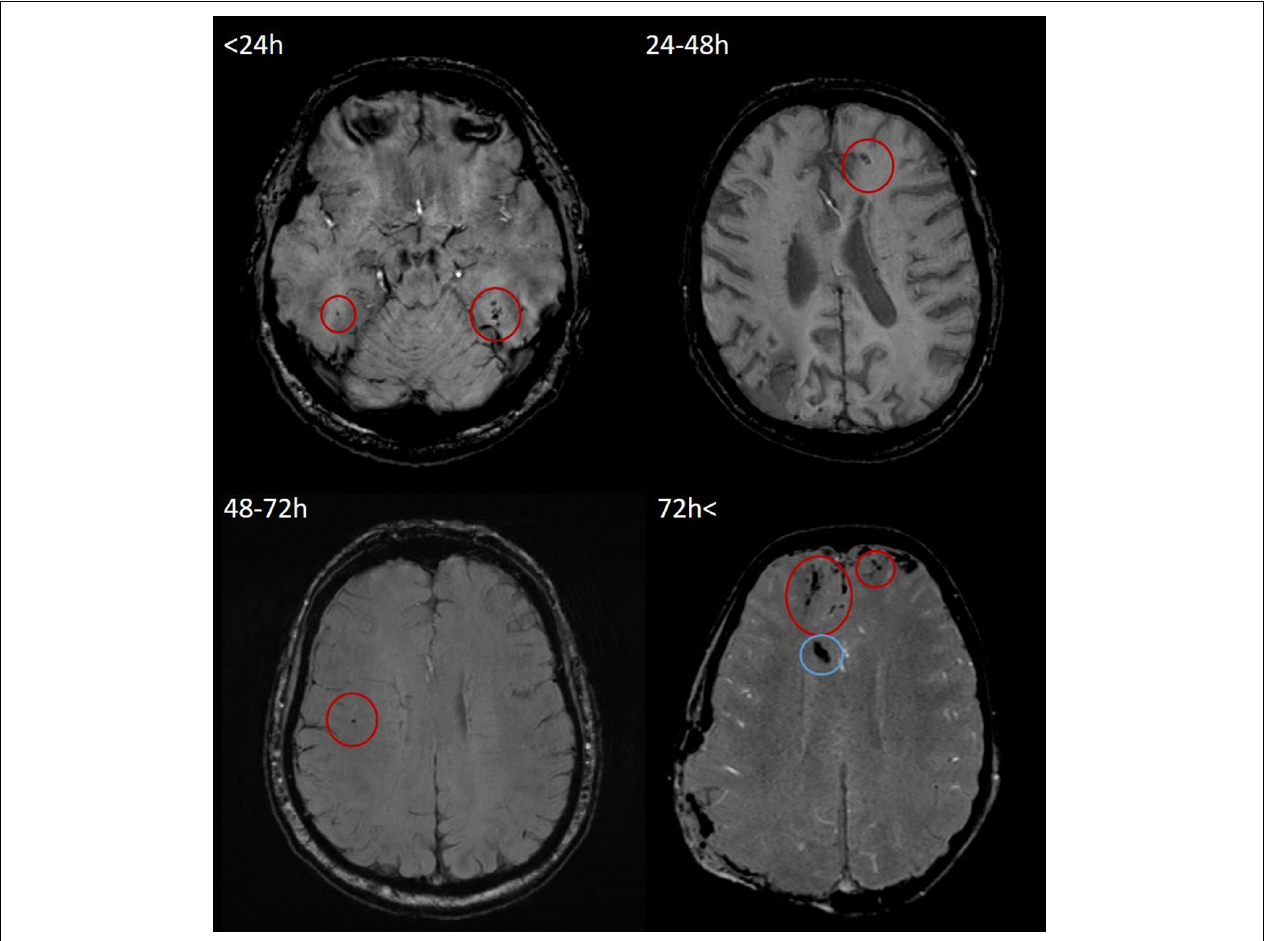
FIGURE 2 | Representative examples of TMBs in SWI images in < 24, 24–48, 48–72, and 72 h < groups. All four SWI measurements were performed on a 3T Siemens Magnetom Prisma MRI scanner. According to Mayo Clinic Classification, both cases (top left, 21-year-old male; top right, 50-year-old male; bottom left, 64-year-old male; and bottom right, 60-year-old male) were classified as severe TBI. TMBs are indicated by red circles. In the bottom left image, hypointensity caused by the intraventricular drain is indicated by a blue circle. TMB, traumatic microbleed; SWI, susceptibility weighted imaging; TBI, traumatic brain